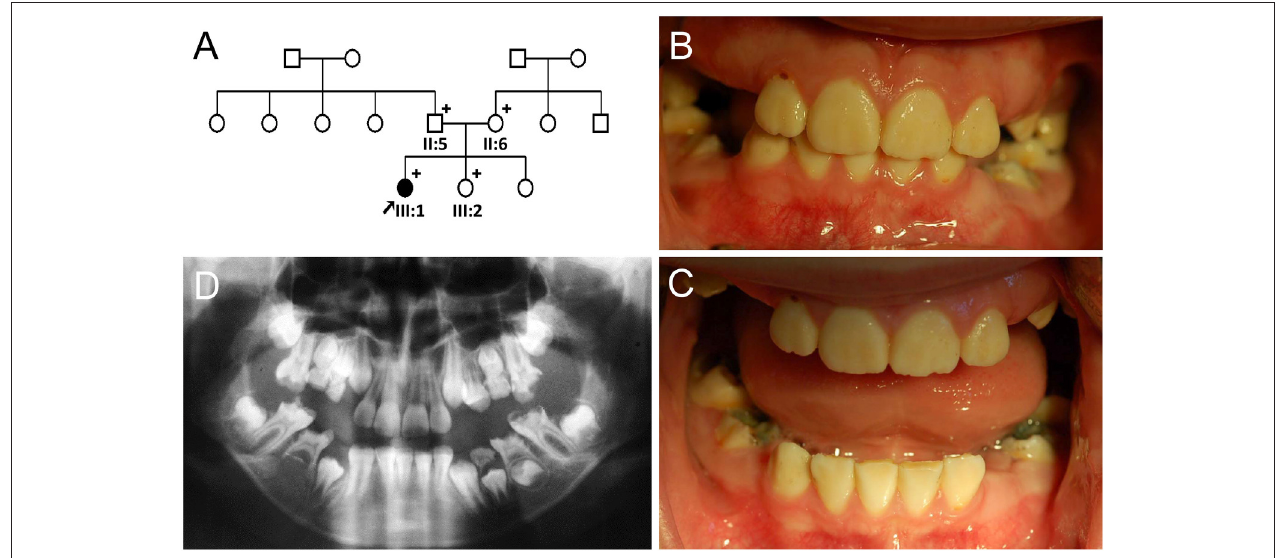
FIGURE 2 | Pedigree and clinical phenotype of the proband of Family 2. (A) Pedigree of family 2. (B) Frontal view of the proband (III:1) at age 10. (C) Frontal view with bite open. (D) Panoramic radiograph of the proband at age 10. Plus symbols indicate individuals who participated in this study.